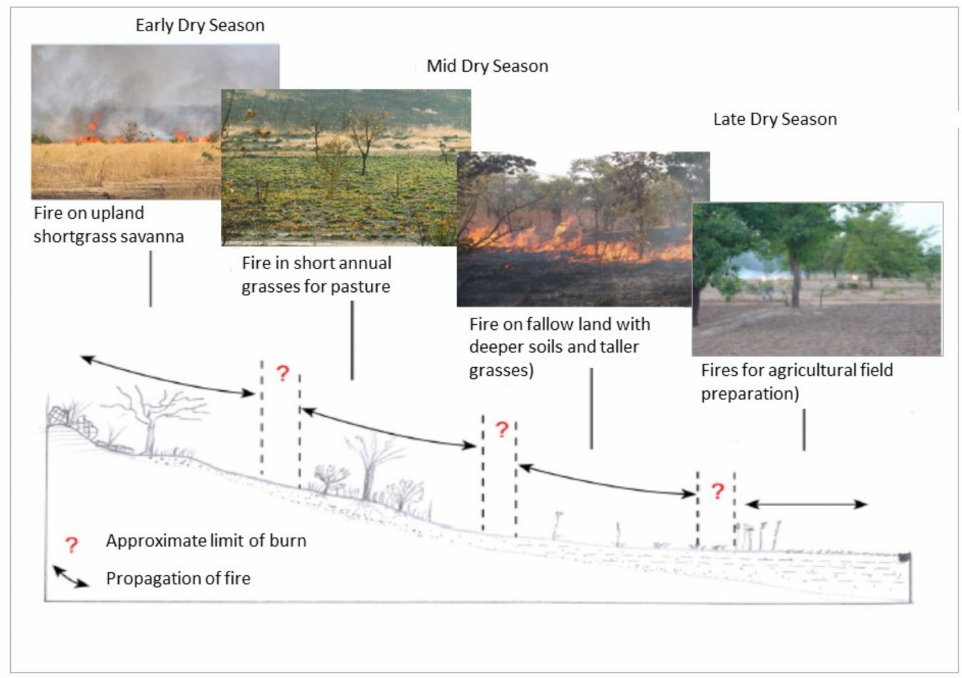
Figure 1. Schematic of spatiotemporal regime of landscape burning based on vegetation type and seasonality for West Africa (modified from